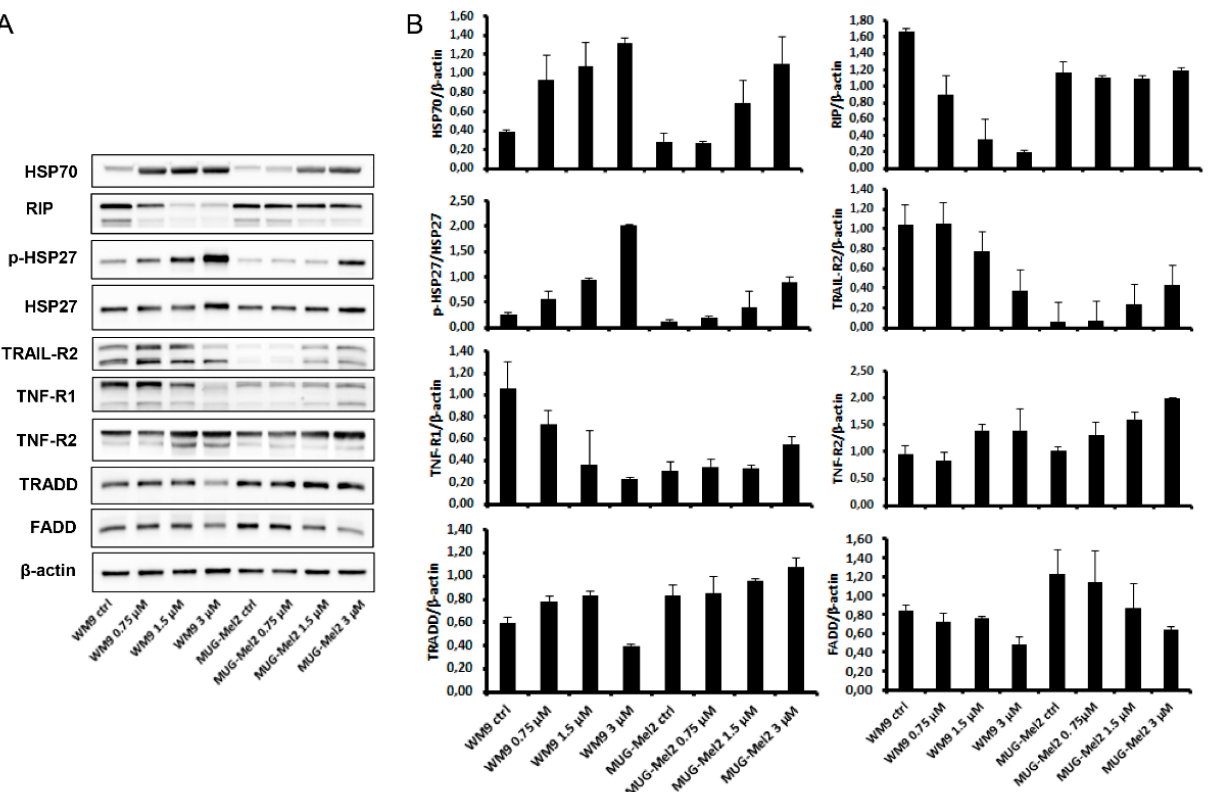
Figure 5. Influence of SK119 treatment on protein expression of death receptors. ( A ) Protein expres- sion analysis of the heat shock proteins HSP27 and HSP90, the tumor necrosis factor (TNF) receptor TNF-R1 and TNF-R2, TRAIL-R2, and the adaptor proteins FADD, TRADD, and RIP after treatment with 0.75 µ M and 1.5 µ M SK119 for 24 h in WM9 and MUG-Mel2 cells. Untreated control cells (ctrl) served as reference value and β -actin was used as loading control. One representative blot out of three is shown; ( B ) Densiometric quantifications are presented (mean ± SD; n = 3). All full-length blots are presented in the Supplementary Materials, Figure S13.